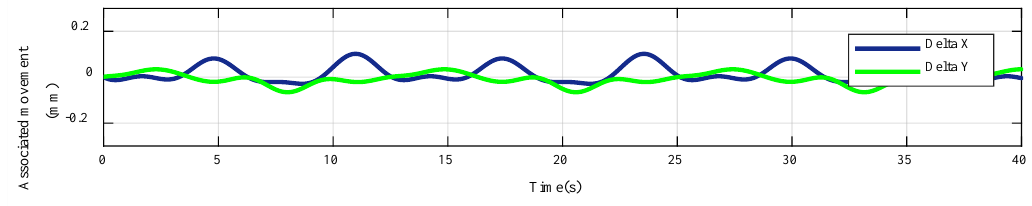
Figure 31. Associated movement of the R-deck along axis x and axis y. The associated movement is caused by the parasitic movement of the parallel platform structure.